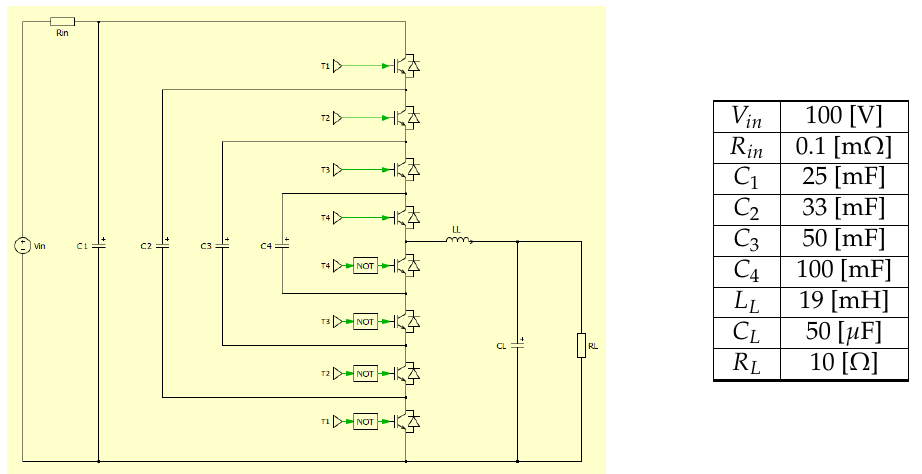
Figure 7. PLECS implementation and parameters of the n = 4 multilevel flying-capacitor converter.